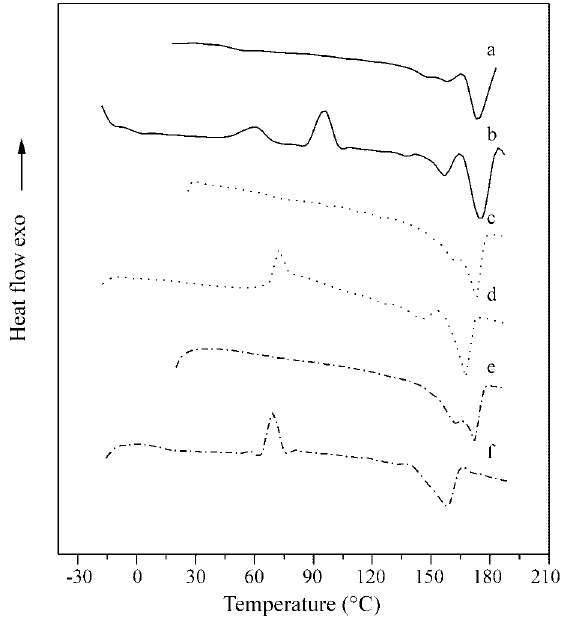
Figure 1. DSC curves for PLLA/PHBV 100/0 blends submitted to different hydrolytic degradation periods, firstheating (a, c,e)for0, 36 and 53 weeks, respectively and second heating (b,d, f)for0,36 and 53 weeks, respectively.